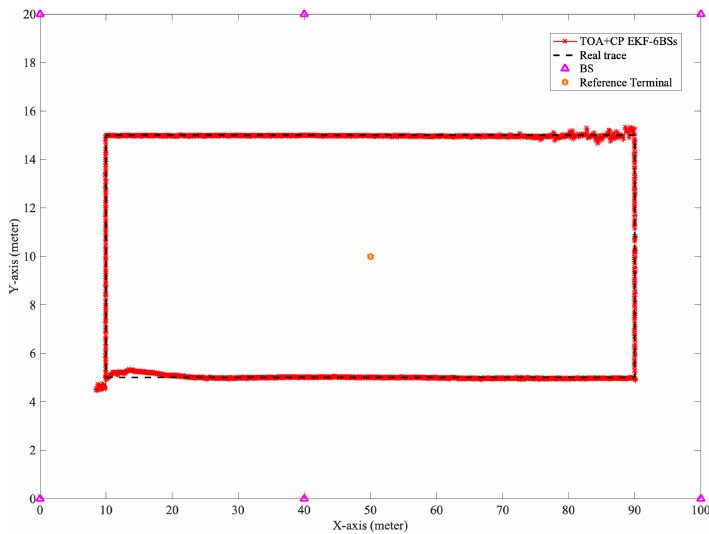
Figure 9. Layout of Indoor - Mixed office scenario.